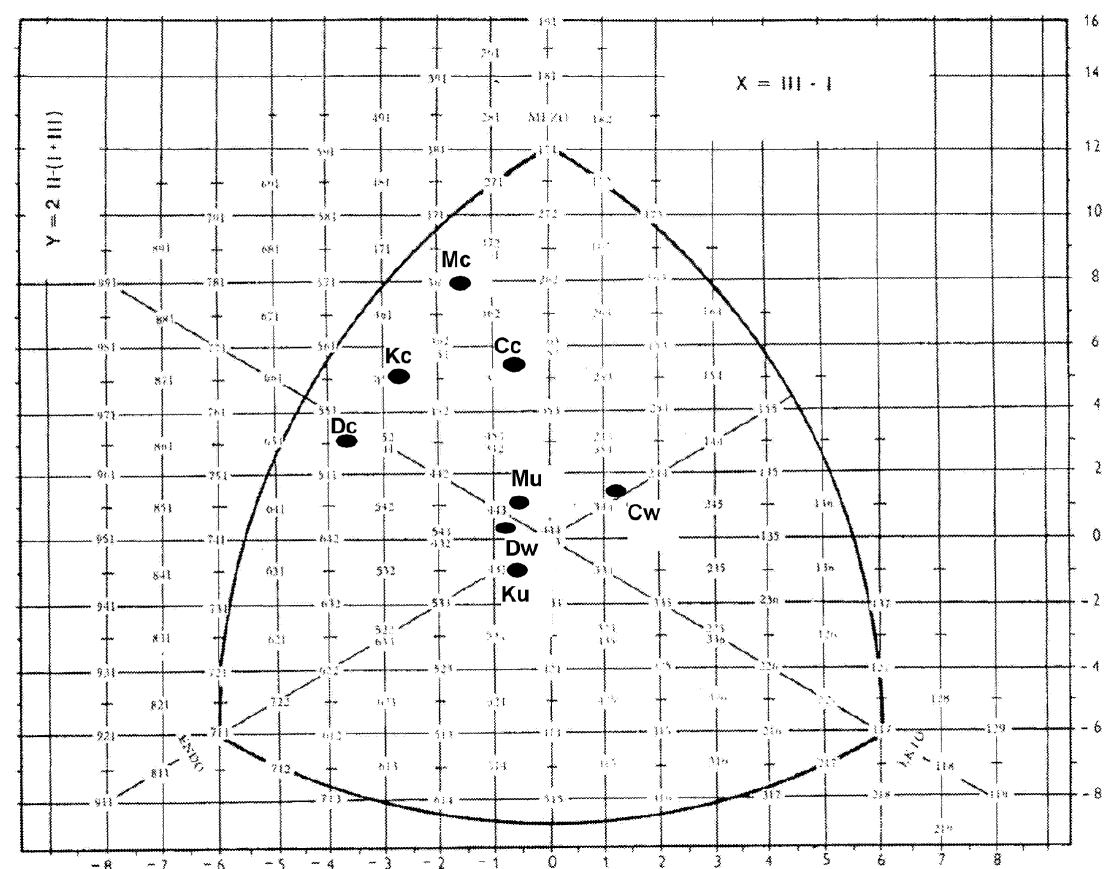
Fig. 1. Distribution of somatotypes amongst female and male weightlifters, adolescents from Wroclaw, and male and female students from Zielona Gora University. Kc – female seniors, Dc – female juniors, Mc – male seniors, Cc – male